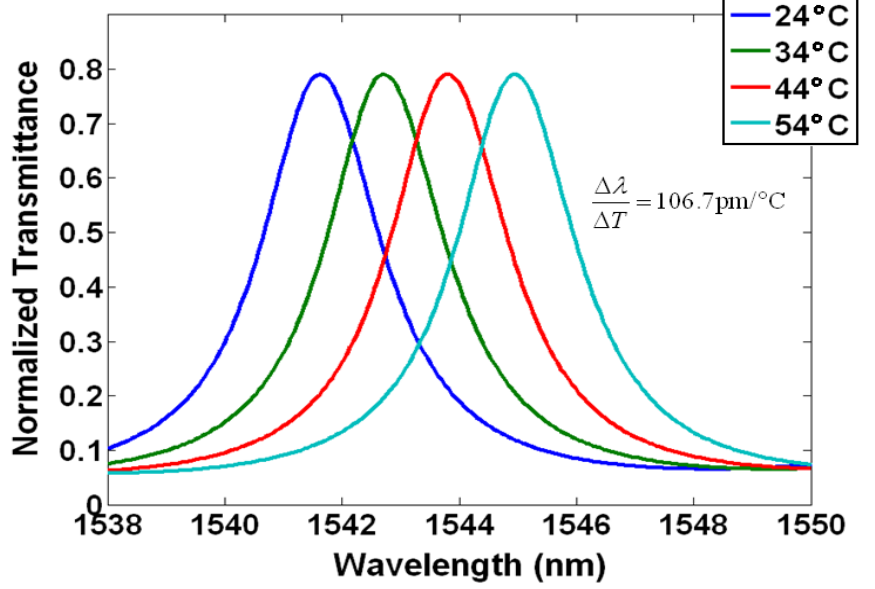
Figure 1. Simulation showing a resonance shift due to rising temperature for a ring resonator clad in silicon dioxide.